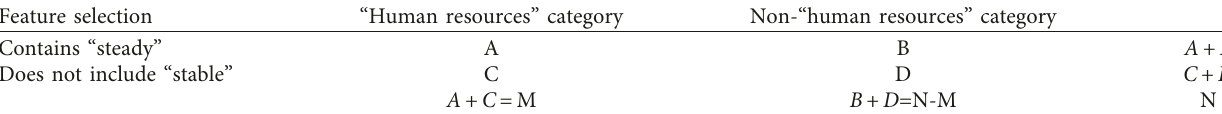
Table 1: Example of chi-square